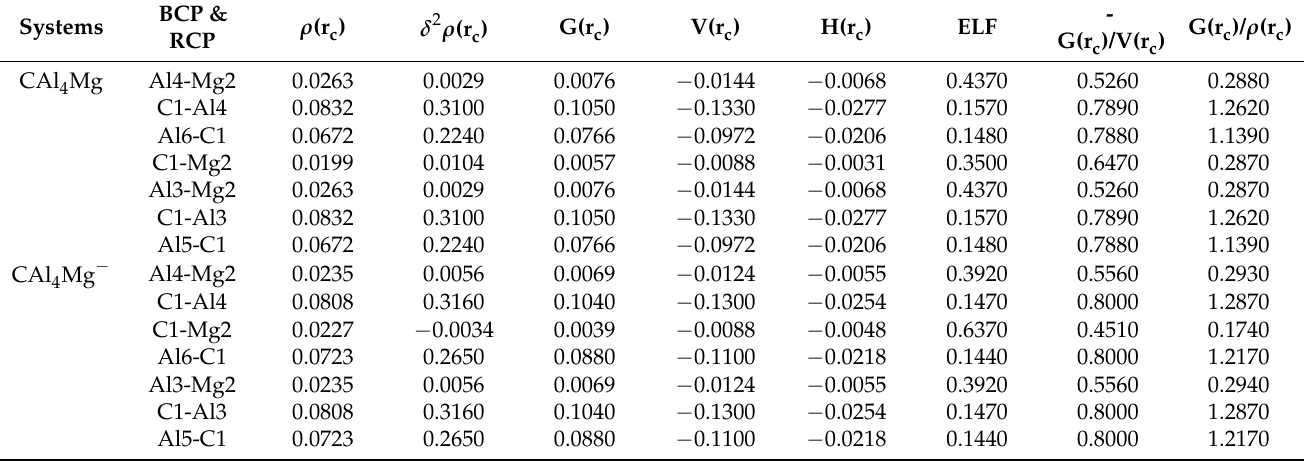
Table 1. Electron density descriptors (in a.u.) at the (3, − 1) bond critical points (BCP) and ring critical point (RCP, C1-Mg2) obtained from the (U) ω B97XD/6-311++G(2d,2p) level for CAl 4 Mg ( 1n ) and CAl 4 Mg − ( 1a ). The topological parameters such as Lagrangian kinetic energy G(r c ), potential energy density V(r c ), energy density E(r c ) or H(r c ), -G(r c )/V(r c ) and G(r c )/ ρ (r c ) at the critical points are also